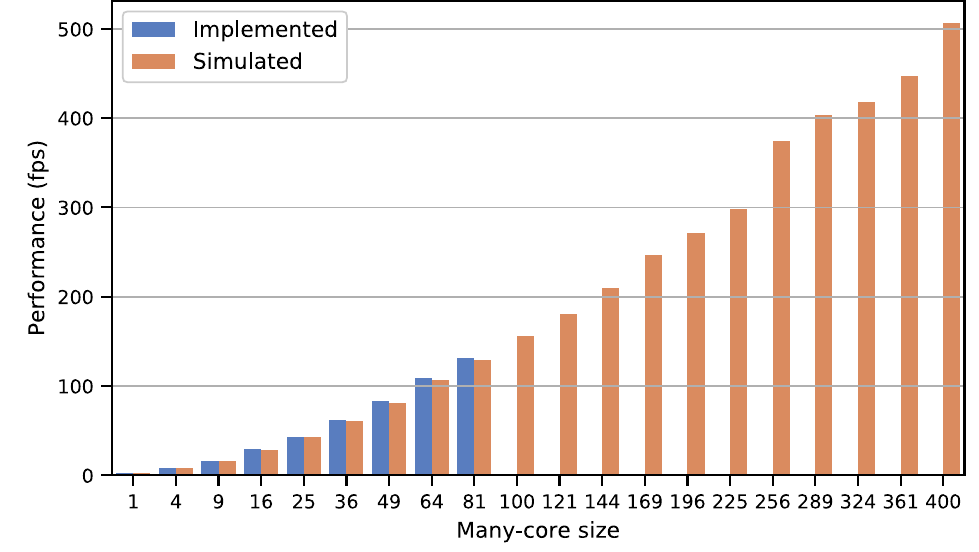
Figure 10. Performance in frames per second comparing implemented and simulated results for the Harris